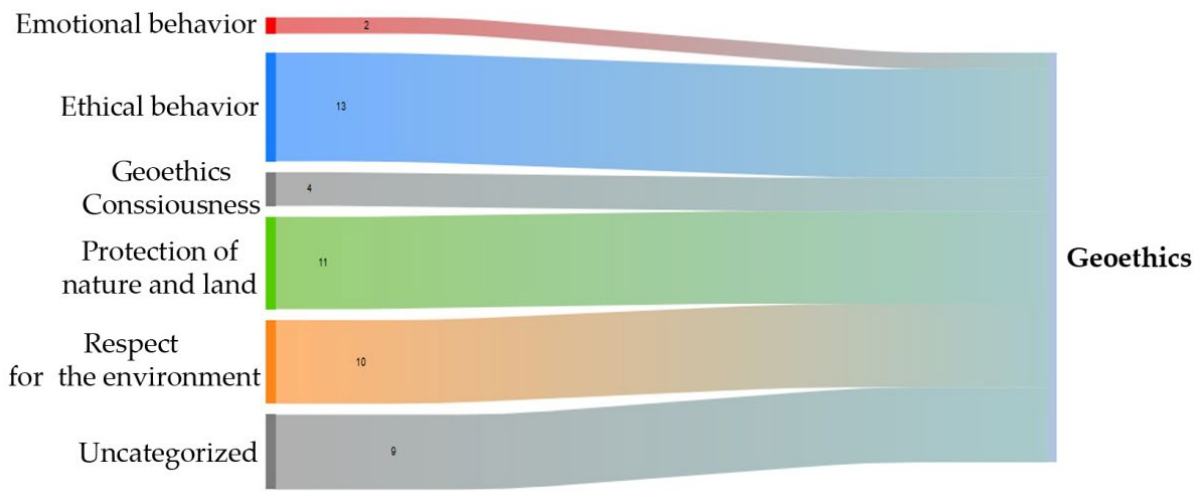
Figure 6. Graph of students’ perceptions (codes) on the concept of geoethics (Sankey diagram).